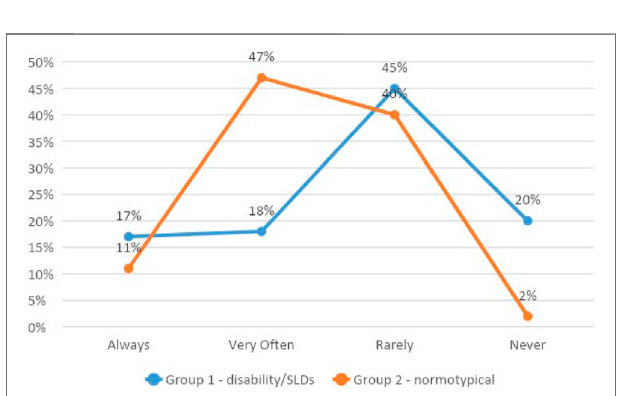
FIGURE 4 | Differences in percentage between groups relative to the item “ Have you felt down-hearted and blue? ” .